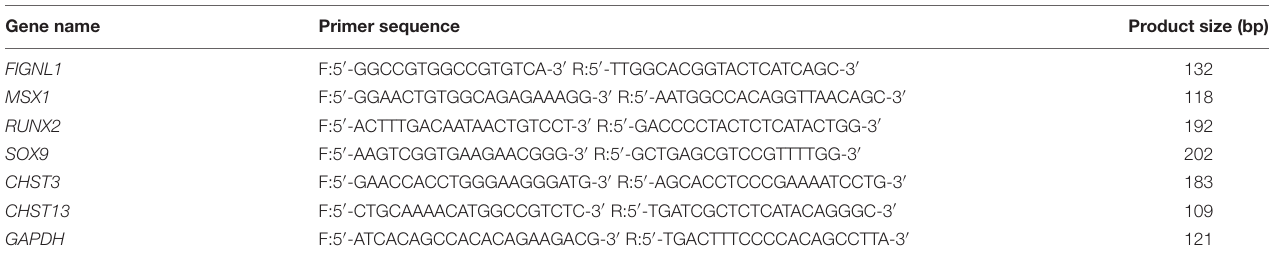
TABLE 3 | Specific primers for